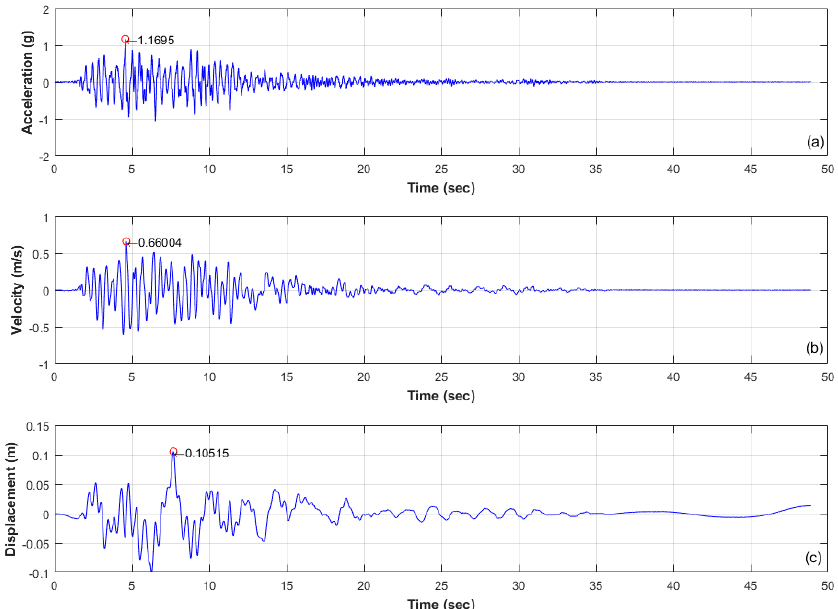
Figure 17. Analysis process for the 10th-story acceleration during the Kobe earthquake using Method 2; ( a ) acceleration; ( b ) velocity; ( c ) displacement.